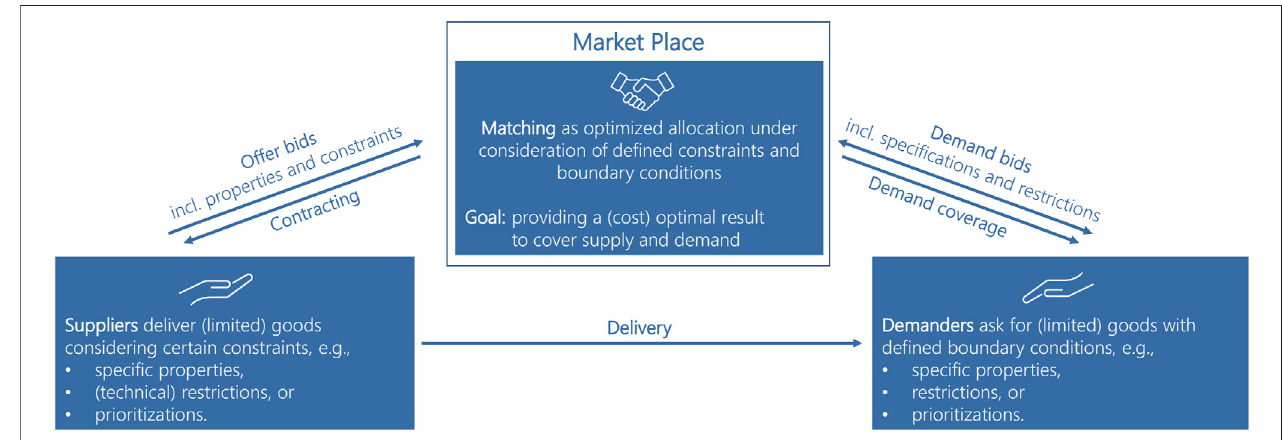
FIGURE 1 | Basic functions and interactions in optimization-based energy